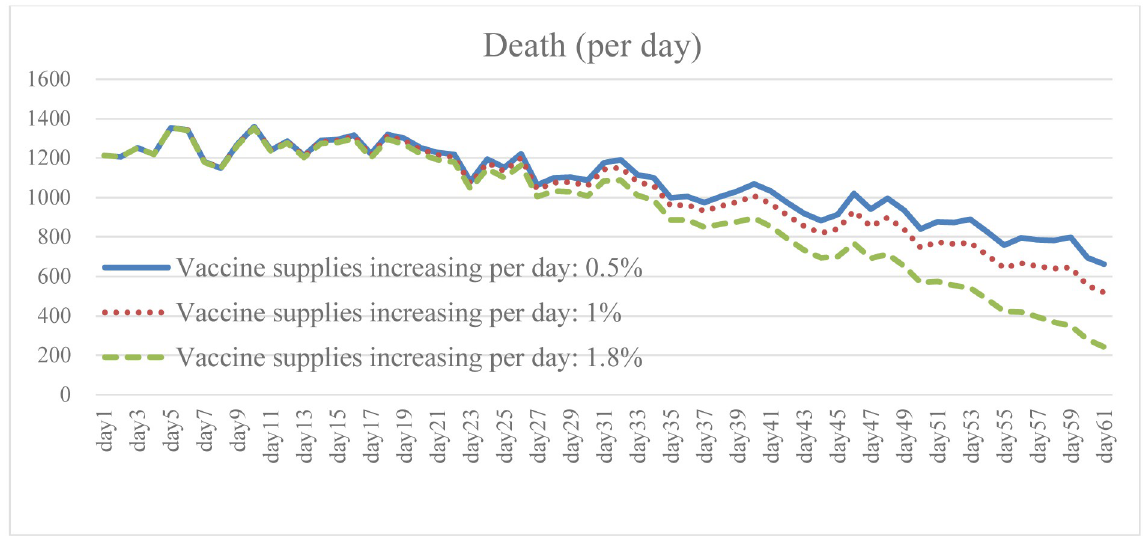
Fig 11. Daily death under different vaccine